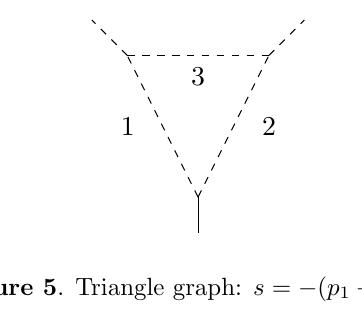
Figure 5 . Triangle graph: s = (cid:0) ( p 1 + p 2 ) 2